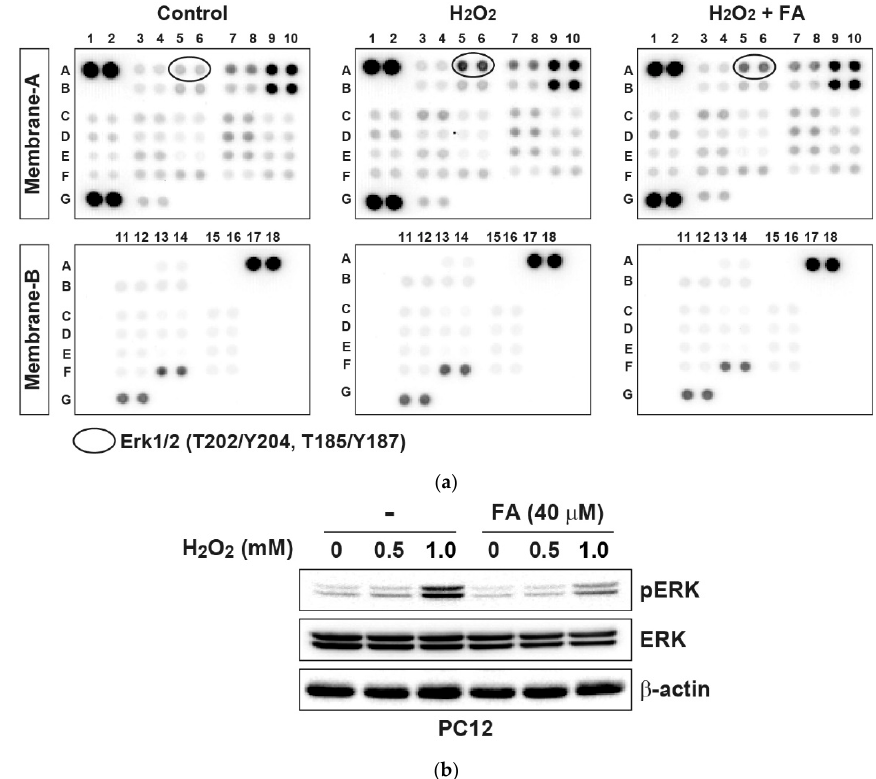
Figure 3. FA inhibits H 2 O 2 -induced phosphokinases in PC12 cells. ( a ) PC12 cells were pretreated with FA (40 µM) overnight and subsequently cultured cells in the absence or presence of H 2 O 2 (0.5 mM) for another 30 min. Cell lysates were evaluated by phosphoprotein kinase antibody array according to the manufacturer’s instructions. The intensity of each dot/phosphoprotein was measured using Image J software. ( b ) Results of the array were validated by Western blot analysis.